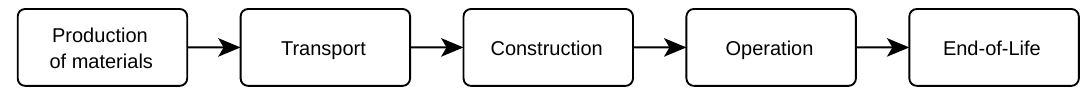
Figure 2. Flowchart of the LCA of a